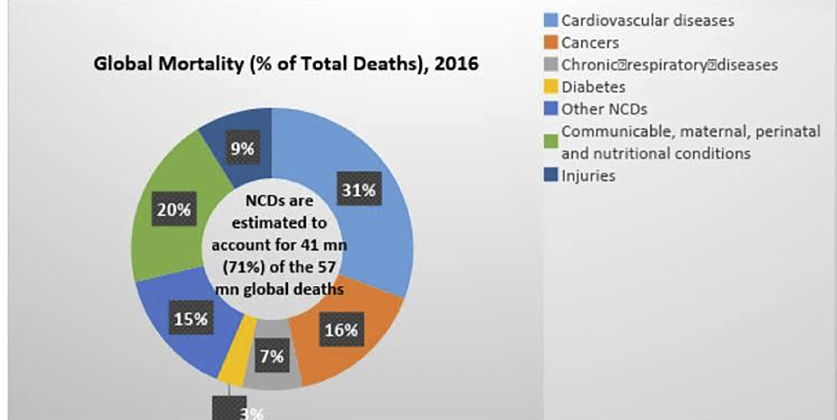
Figure 1. Global mortality, % of